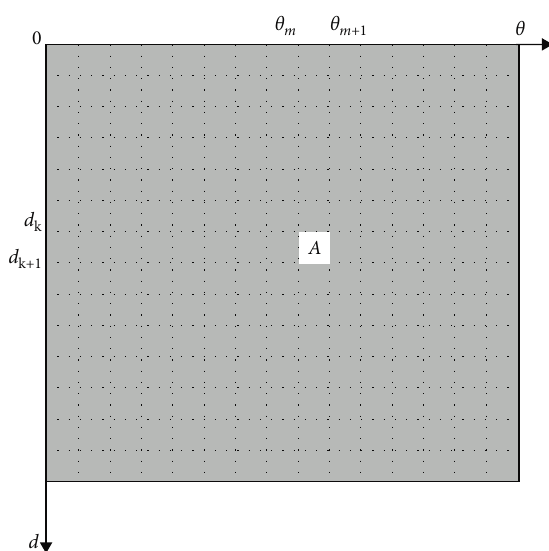
Figure 5: The representation of distance-angle distribution matrix representation of the model.